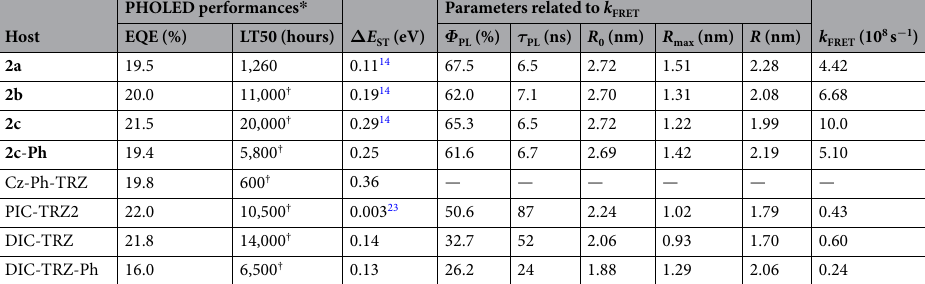
Table 1. Performances of PHOLEDs using several TADF hosts and parameters related to k FRET . * Measured at 1 mA cm − 2 (corresponds to the luminance of approximately 1,000 cd m − 2 ). EQE: external quantum efficiency. † Estimated lifetime by fitting curve 26 (see Supplementary Section 5). Δ E ST : Energy gap between singlet and triplet excited states (see Supplementary Sections 1 and 4). Φ PL , τ PL : Photoluminescence quantum yield and radiation lifetime of host (see Supplementary Section 7). R 0 : Estimated critical distance for the concentration quenching (Förster radius, see Supplementary Section 7). R max : Maximum molecular radius of host calculated by using Gaussian 09. R : Separation between the centres of the host and Ir(mppy) 3 . k FRET : Estimated Förster resonance energy transfer rate from host to Ir(mppy) 3